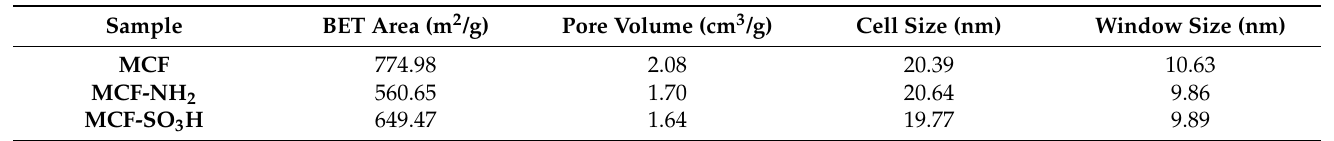
Table 4. Surface area, pore volume, and pore size for MCF silica before and after functionalization with APTES (MCF-NH 2 ) and MPTMS (MCF-SO 3 H).